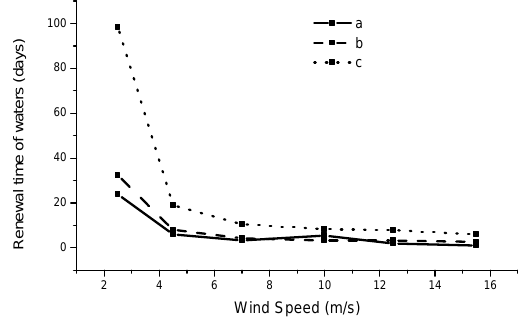
Figure 5. Waters’ renewal time for different values of wind speed (case a, b,